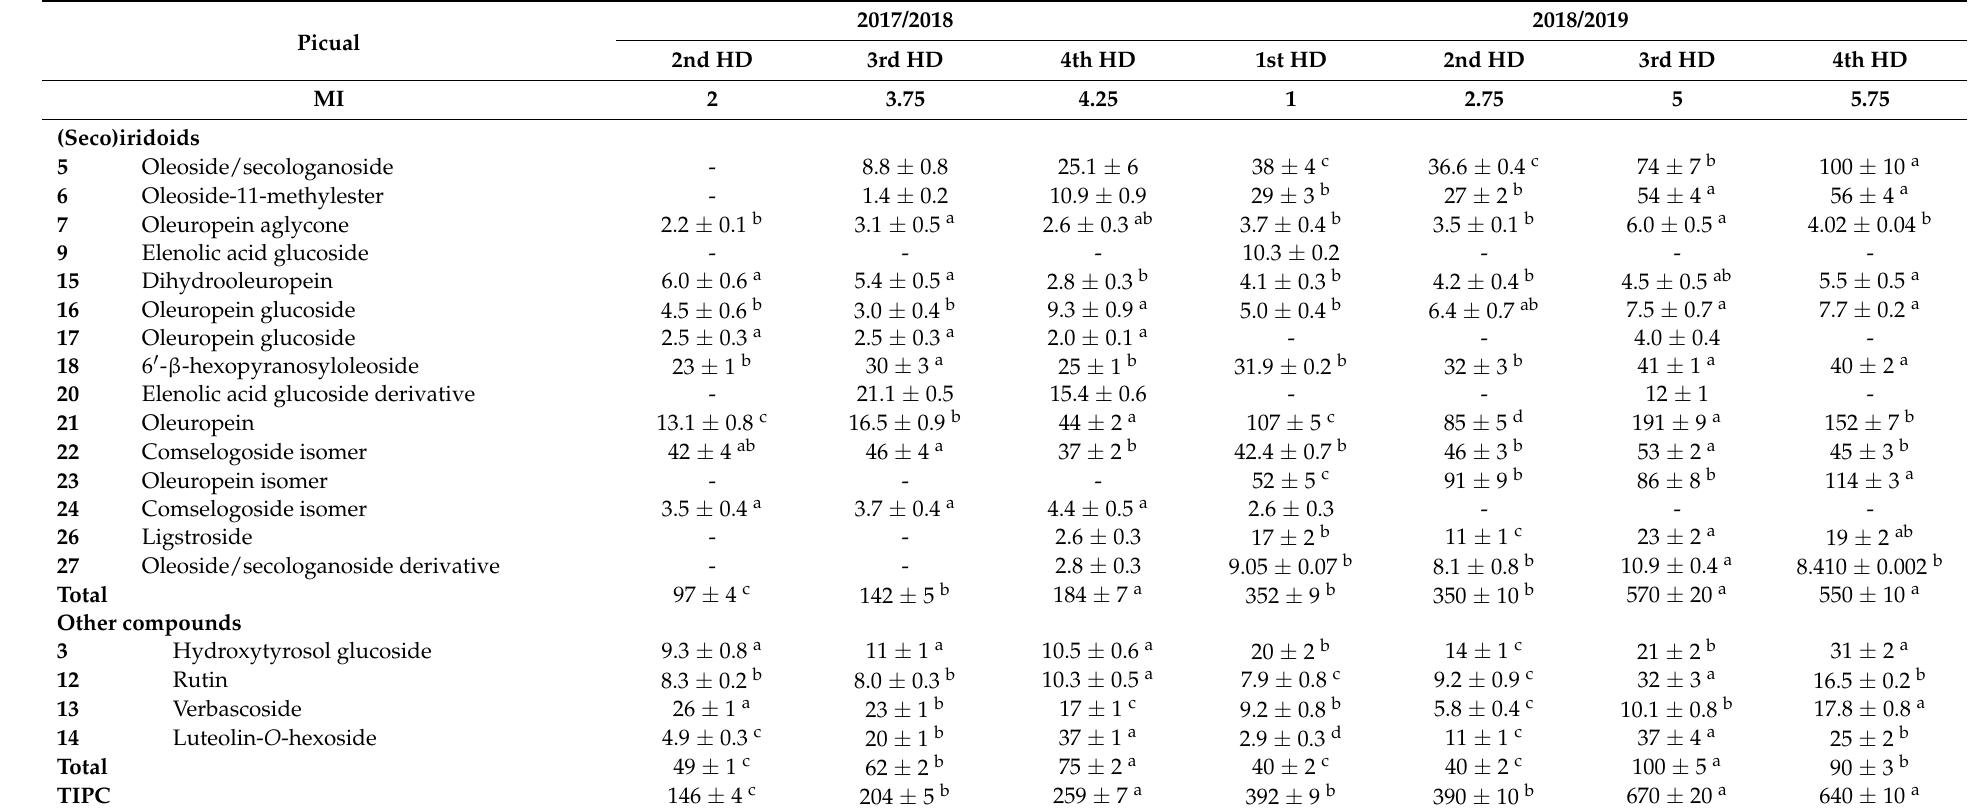
Table 4. Quantification of phenolic compounds in olive fruits (cv. Picual) at different harvest times and harvest